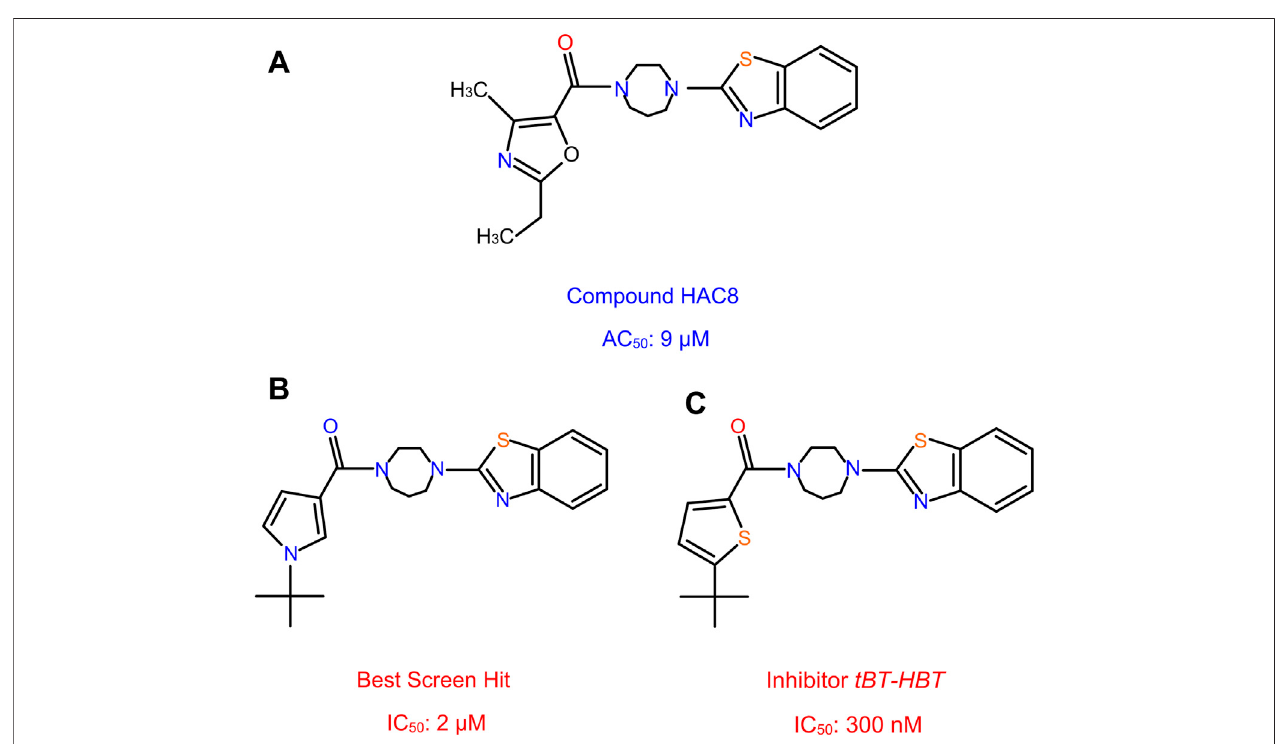
FIGURE 12 | Non-covalent activator and inhibitor compounds. HAC8, a novel class of non-covalent modulator compound with an AC 50 of 9 µM (A) . The best screen hit inhibitor compound with an IC 50 of 2 µM (B) . The thiophene analog compound of the best screen hit, named tBT-HBT , the fi rst nano-molar non-covalent inhibitor of HhC cholesterolysis, with an IC 50 of 300 nM (C)